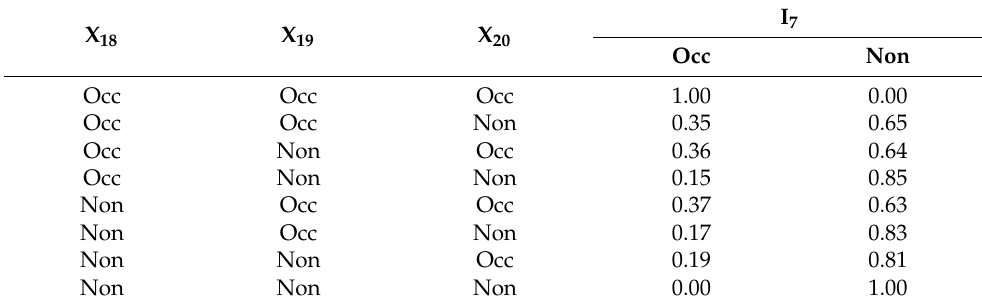
Table A6. The CPT of event I 7 (Medium content; Occ: occurred; Non: non-occurred).